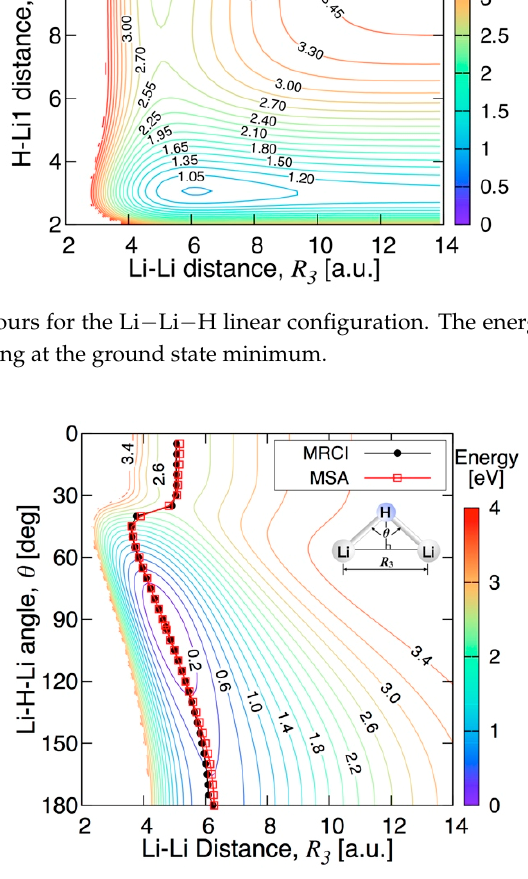
equally spaced by 0.2 eV, starting at the ground state minimum.